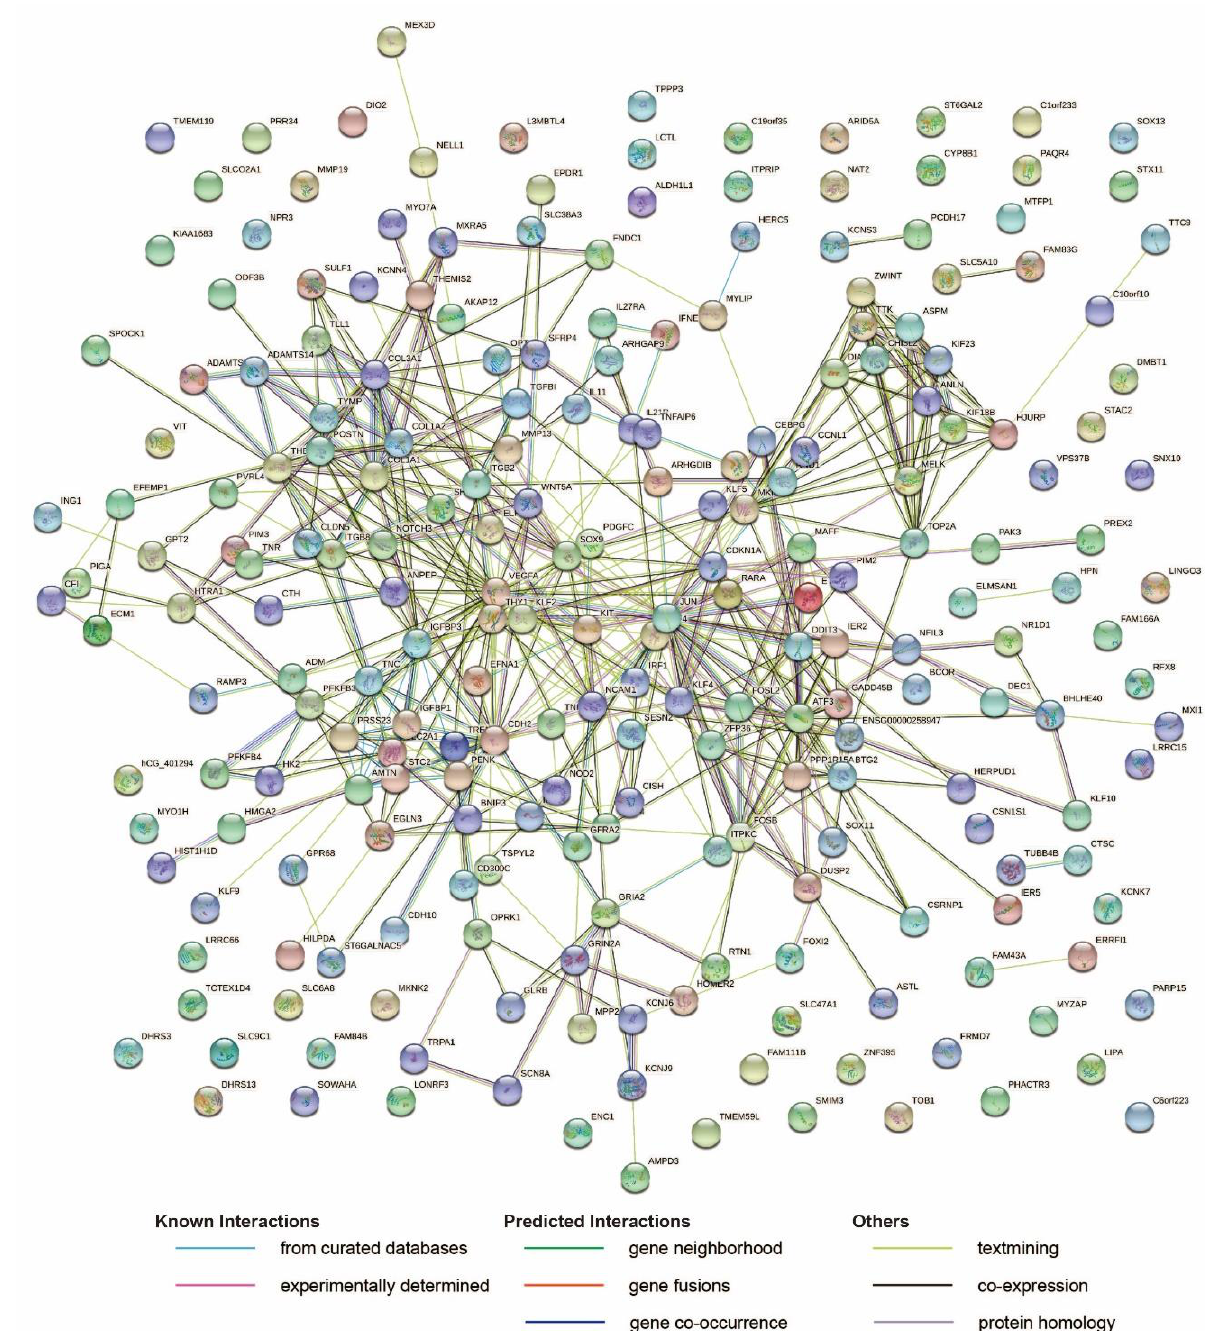
Figure 4. The protein–protein interaction network generated on the SPRING server against the Homo sapiens gene database. The STRING server identified 230 genes among the input of the 271 common DEGs in cartilage shared by both genders. The network nodes represent proteins. The empty nodes display the proteins without a known or predicted 3D structure, while the filled nodes illustrate those with a known or predicted 3D structure. The edges represent protein–protein associations: light blue–known interactions from curated databases; burgundy–experimentally determined known interactions; green–predicted interactions by gene neighborhood; orange–predicted interactions by gene fusions; dark blue–predicted interactions by gene co-occurrence; yellow–text mining; black–co-expression; purple–protein homology.